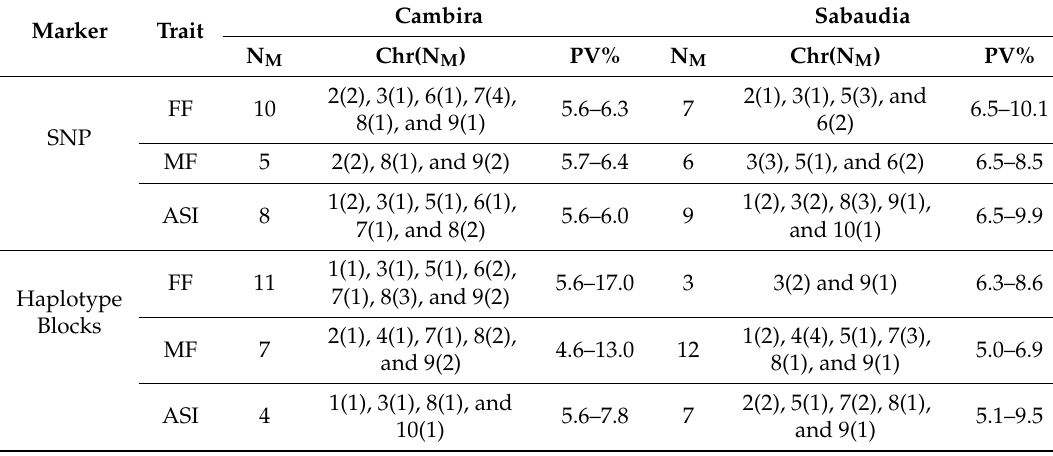
Table 2. Summary of the associations detected by a genome-wide association study (GWAS), based on in haplotype blocks and SNP for the traits of female / male flowering time (FF and MF, respectively) and anthesis–silking interval (ASI) measured in inbred lines of tropical